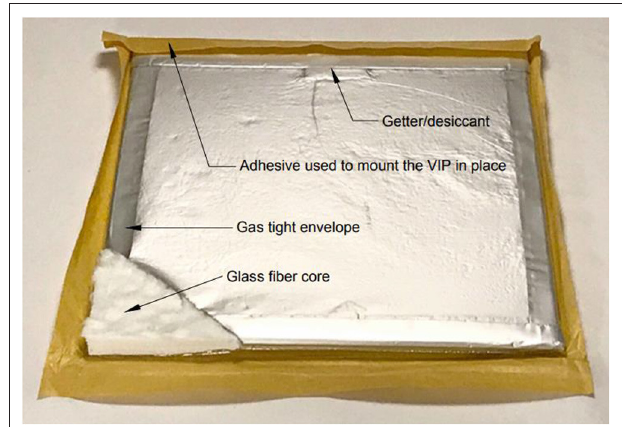
FIGURE 1 | Schematic of a glass fiber core VIP. One corner of the gas-tight envelope has been removed to show the evacuated open-pore core. The getter/desiccant is in a sachet in the raised area at the top-center. The brown wax paper backing covers the adhesive that is used to mount the VIP in